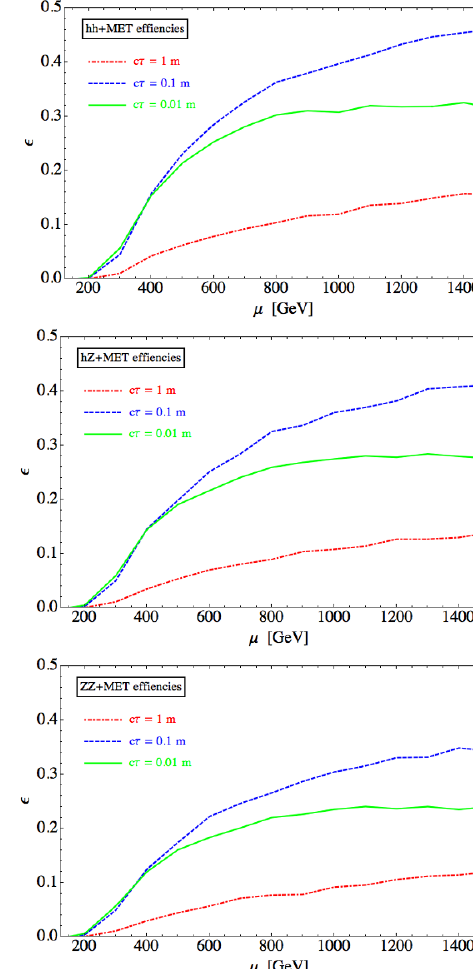
, hZ + E / , ZZ + E / . Left: T T T